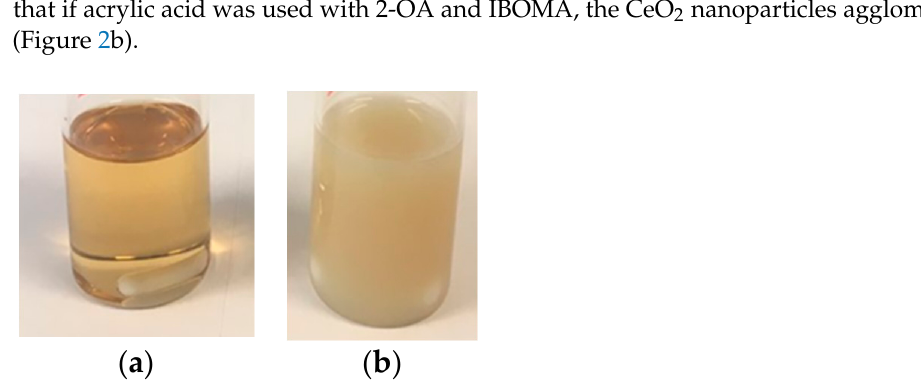
Figure 4. Water uptake experiment results of neat polymer film and the hybrid one. Table 3. Water sensitivity of the neat polymer film and the hybrid one. Film Contact Angle to Water ( ° ) Water Uptake after 14 Days (%) Bioacrylic 92 ± 3 7.0 ± 0.3 CeO 2 -Bioacrylic 92 ± 1